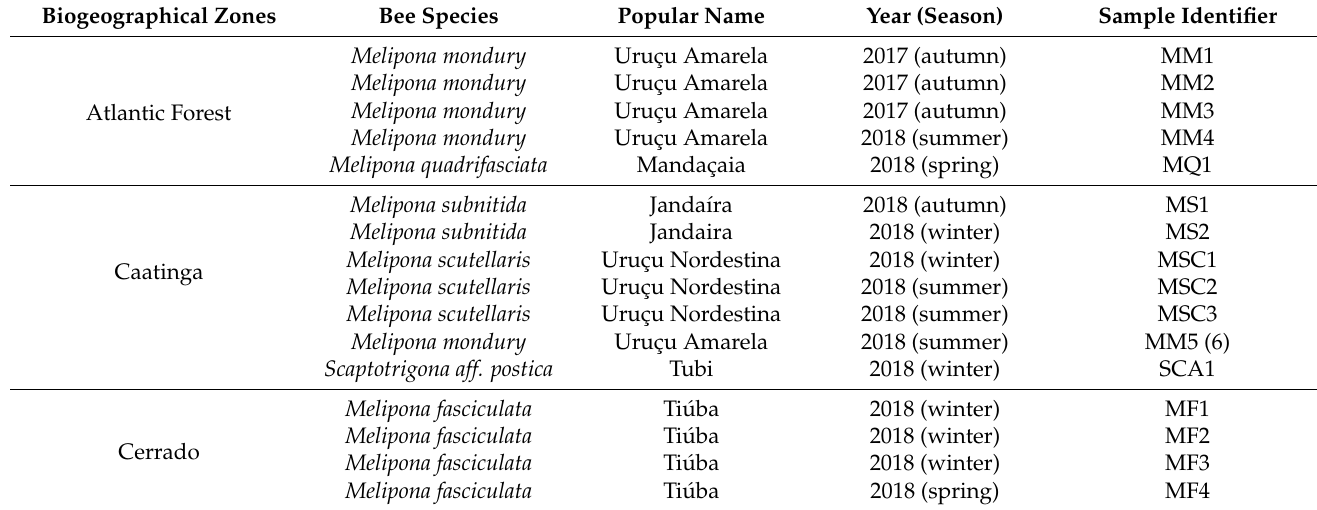
Table 1. Details of stingless bee species providing